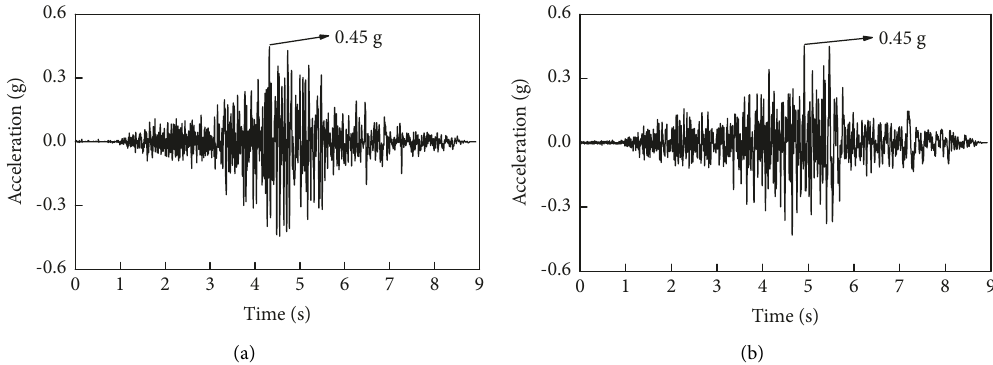
Figure 4: Shaking table test used waves for (a) in (x) direction and (b) in (y) direction.